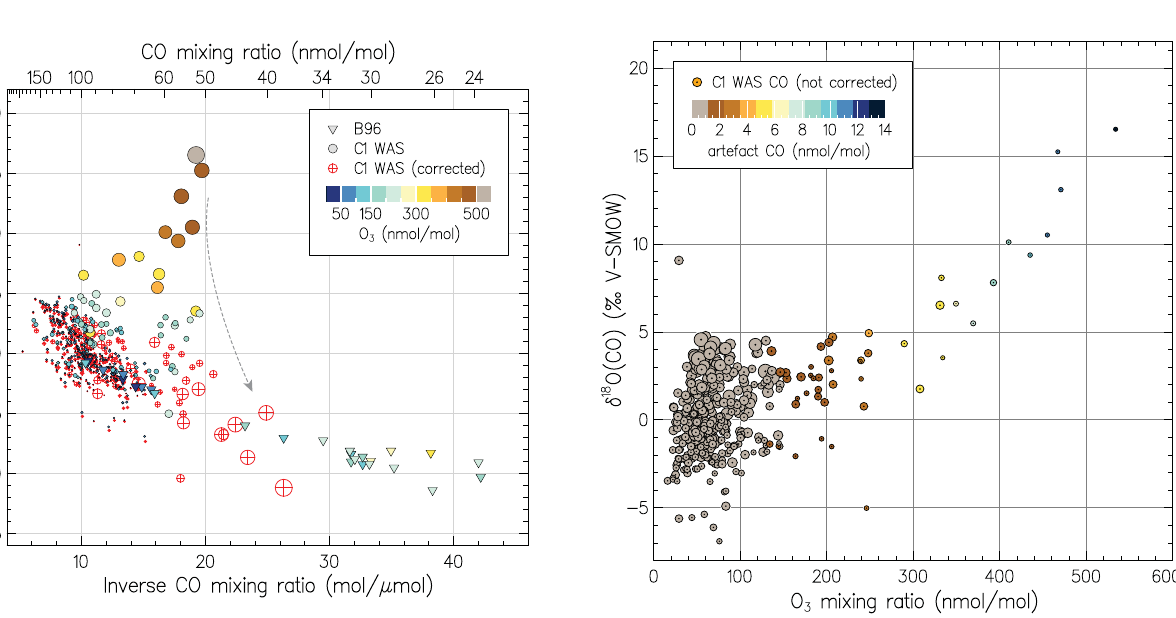
Figure 4. Measured C1 WAS δ 18 O(CO) (not corrected for artefacts) as a function of concomitant O 3 mixing ratio. Symbol colour de- notes the artefact CO component (integral [CO c ] per each WAS); symbol size scales proportionally to the WAS CO mixing ratio cor- rected for artefacts (see Sect. 3 for